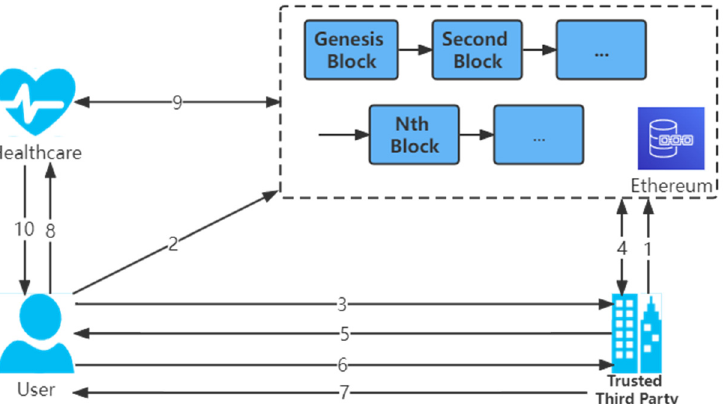
Figure 2. The existing identity model. (1) A trusted third-party organization deploys a smart contract. (2) The user uploads the public key to Ethereum for account generation. (3) The user sends the